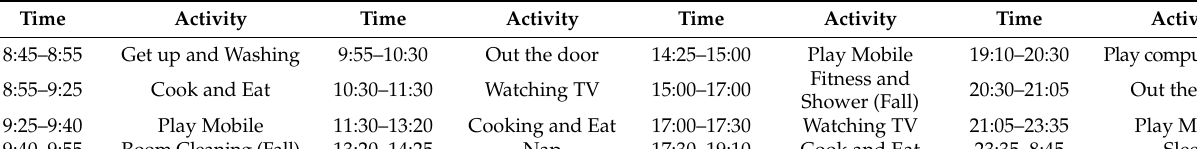
Table 3. Twenty-four hour activity record of experimenter 2.